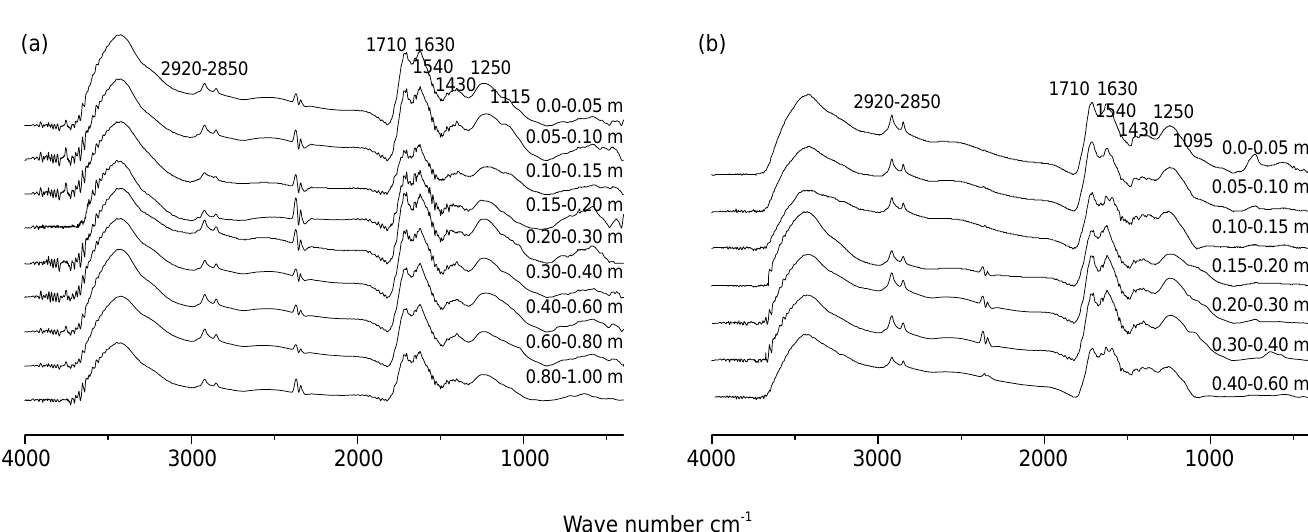
Figure 3. Fourier transform infrared spectroscopy (FTIR) spectra of (a) humic acids of a Fluvaquentic Humaquepts (FH) and (b) humin of Typic Haplosaprists